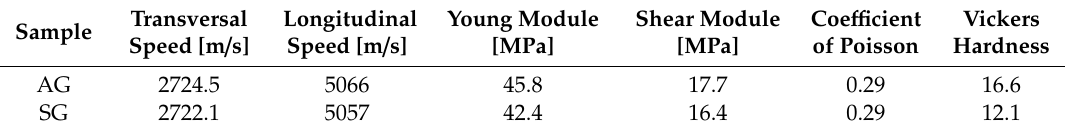
Figure 9. Transmission pulse echoes of AG ( a ) and SG ( b ) gypsum samples. Table 6. Mechanical properties of the two Moroccan gypsum